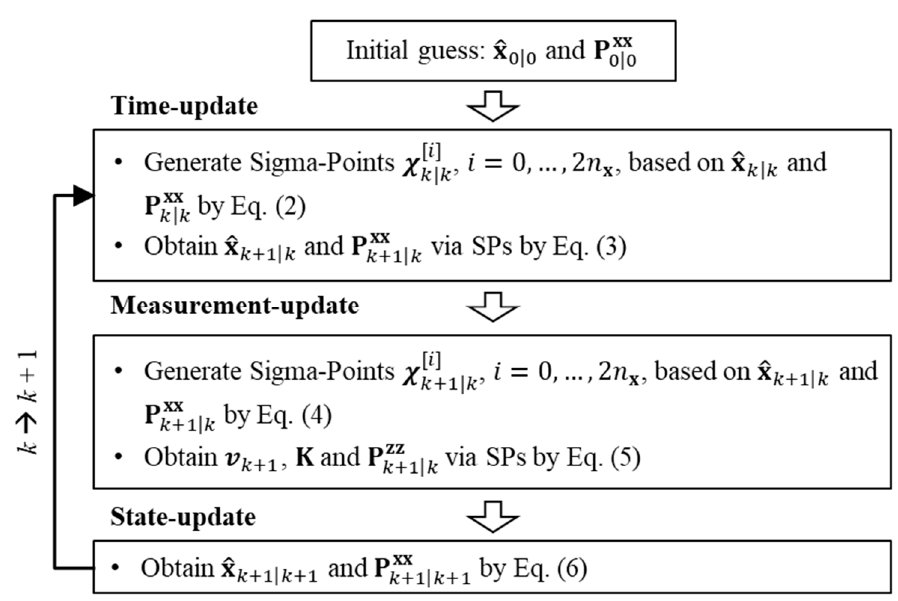
Figure 1. Algorithm of Unscented Kalman Filter (UKF).